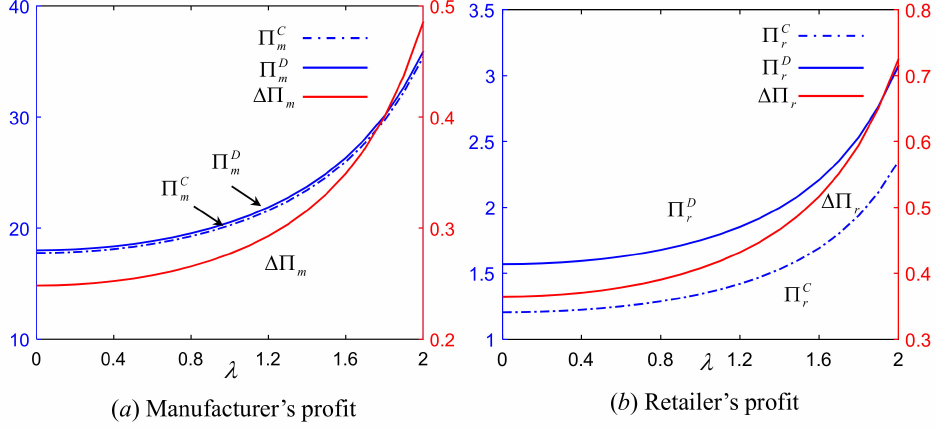
Figure 1. The effect of λ on each party’s profit